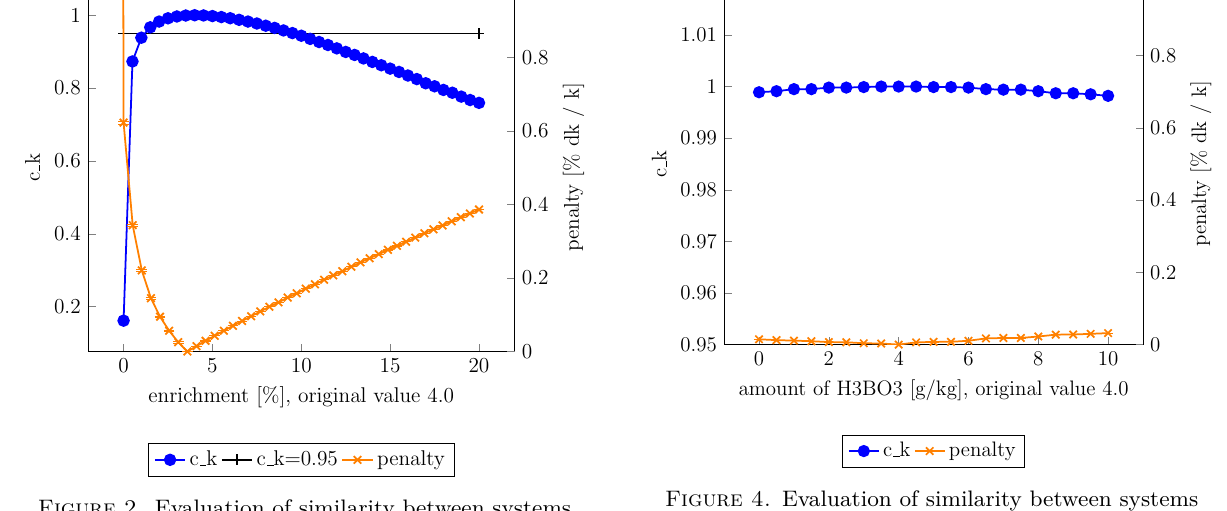
BO in moderator. 3 3